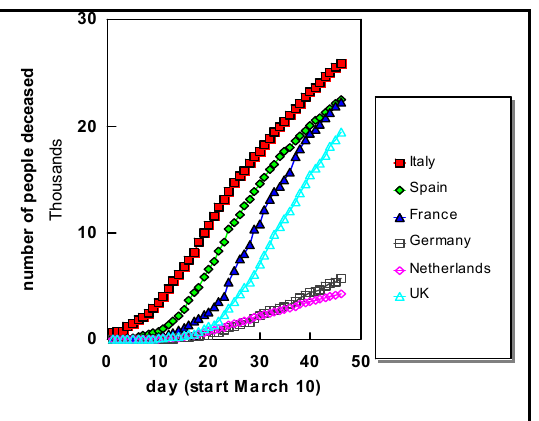
Figure 2. Number of deaths (ordinate) in several European countries (as indicated) during the period 10 March–24 April 2020. All curves show exponential behaviour from the outset, with possible indication of flattening at a later stage (see text for discussion).